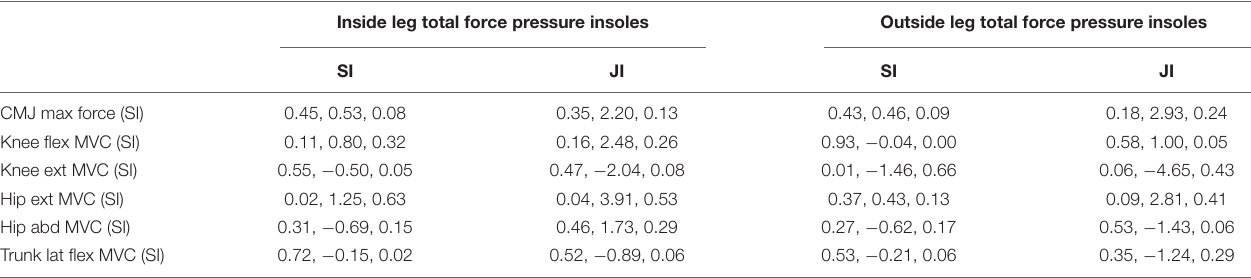
TABLE 4 | Triplets ( p -value, coefficient in the linear regression model, R 2 ) for each pair: independent (laboratory) variable (rows) and dependent (on-snow) variable (columns) used for testing hypothesis H2.